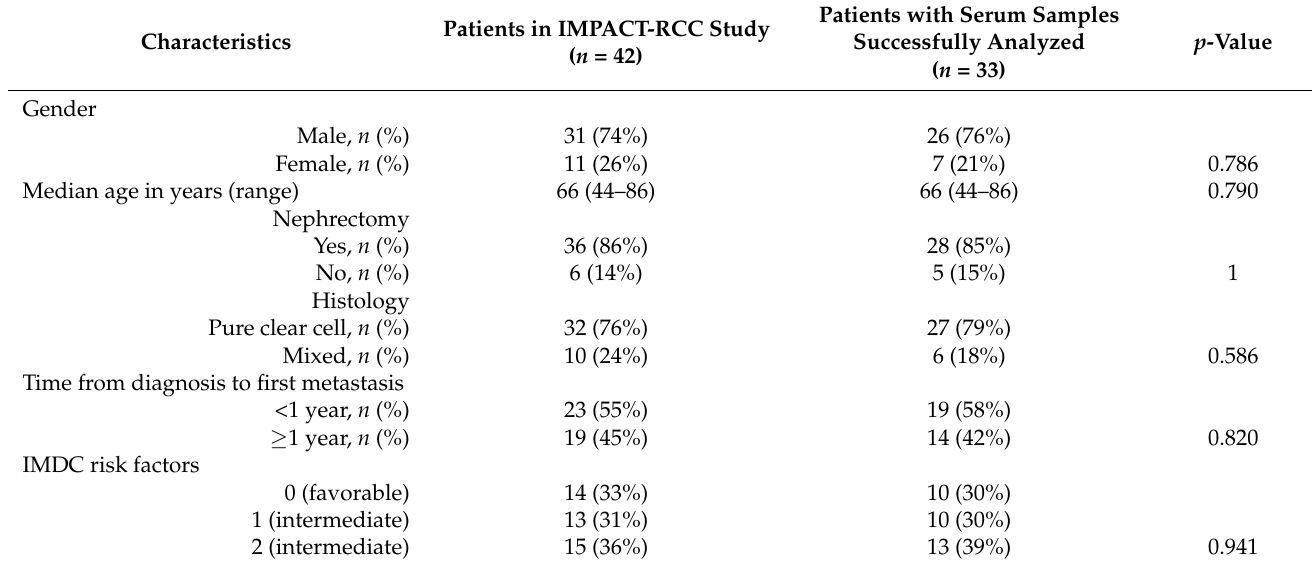
Table 1. Patient demographics and clinical